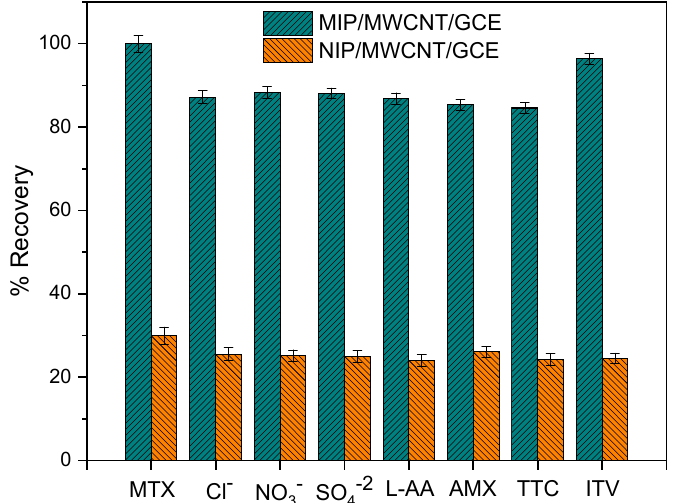
Figure 10. Interference study conducted using MIP/MWCNT/GCE and NIP/MWCNT/GCE. Table 1. Results obtained from the analysis of selectivity of MIP/MWCNT/GCE and NIP/MWCNT/GCE in terms of the quantification of methotrexate in the presence of interfering mol- ecules.